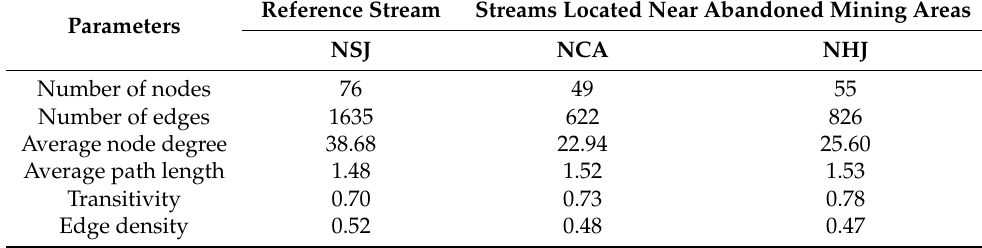
Table 1. Parameters of the benthic macroinvertebrate co-occurrence network (NSJ: Songjeonrichoen stream, NCA: Cheulamcheon stream, and NHJ: Hwangjicheon stream).